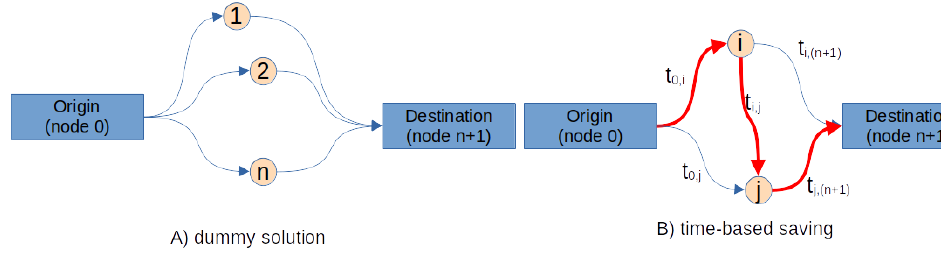
Figure 3. Resolution process implemented into the PJS